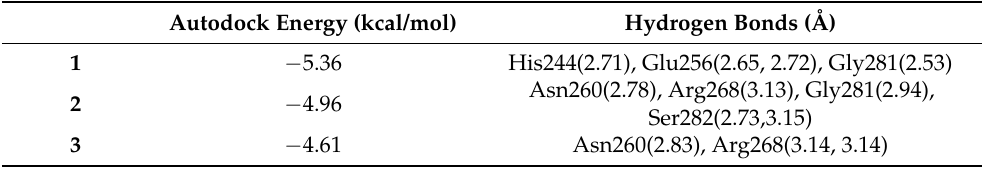
Table 2. Hydrogen bonds analysis of the compounds with